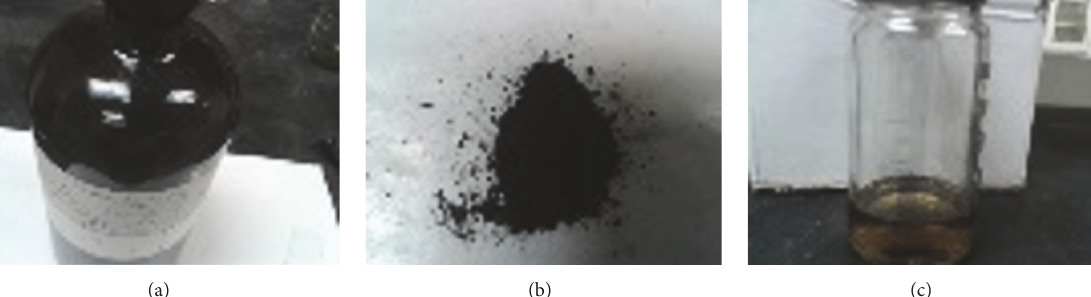
Figure 3: The schematic of the unknown black sludge deposit that was found in the diesel oil tank in a refinery: (a) the as-received sample, (b) dichloromethane insoluble, and (c) dichloromethane